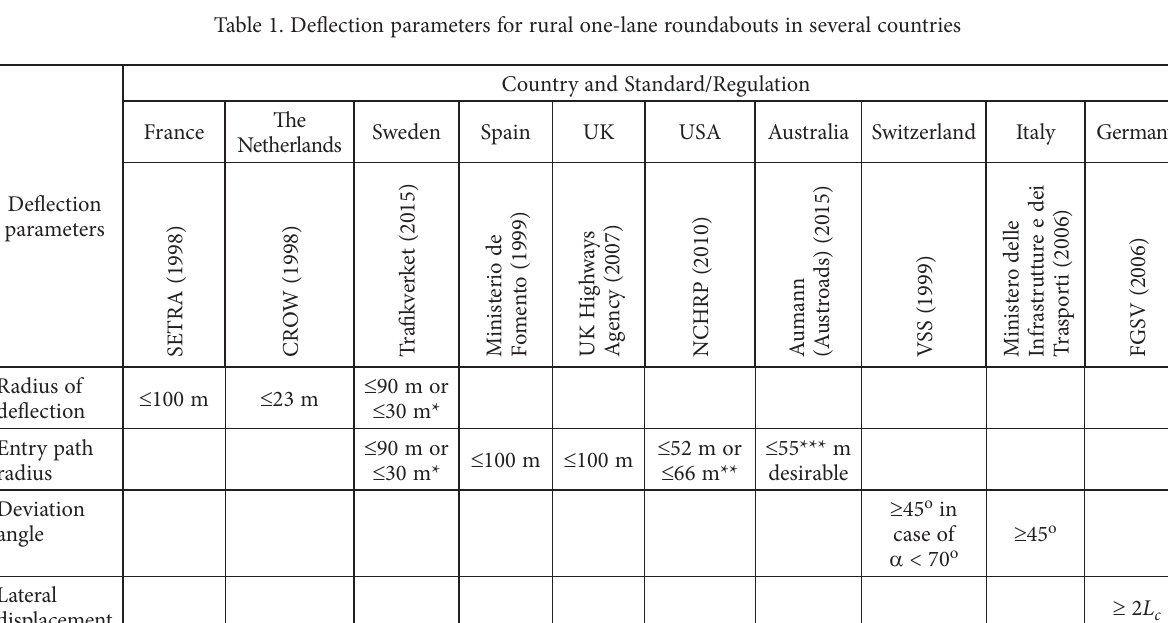
Table 1. Deflection parameters for rural one-lane roundabouts in several countries Country and